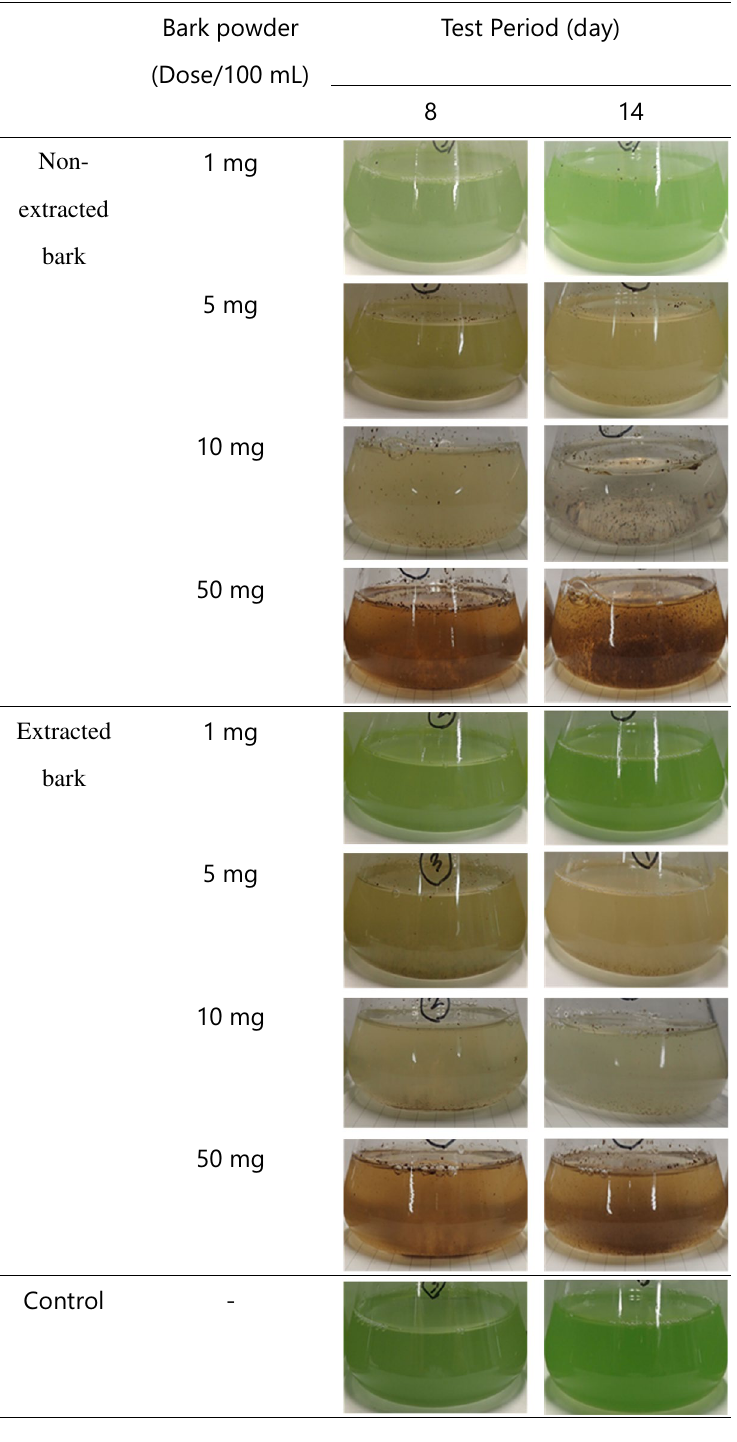
Table 2 Photographs of culture media at 8 days and 14 days from the start of the